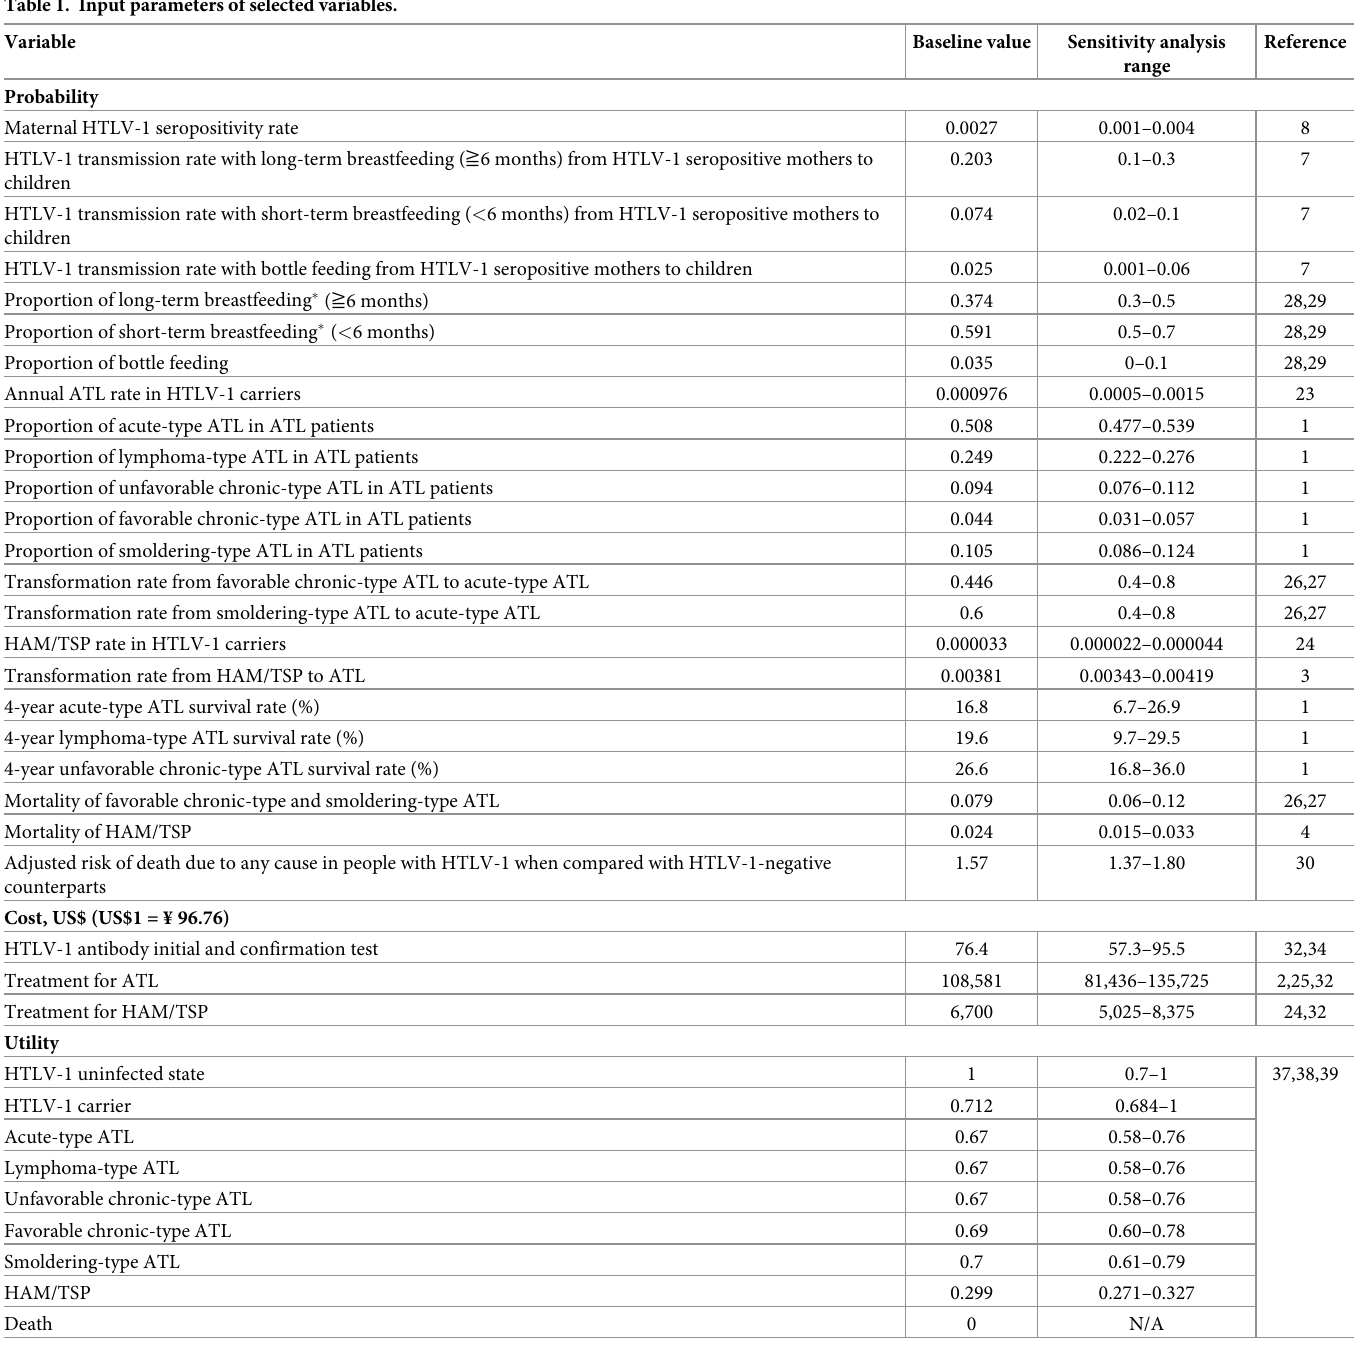
Table 1. Input parameters of selected